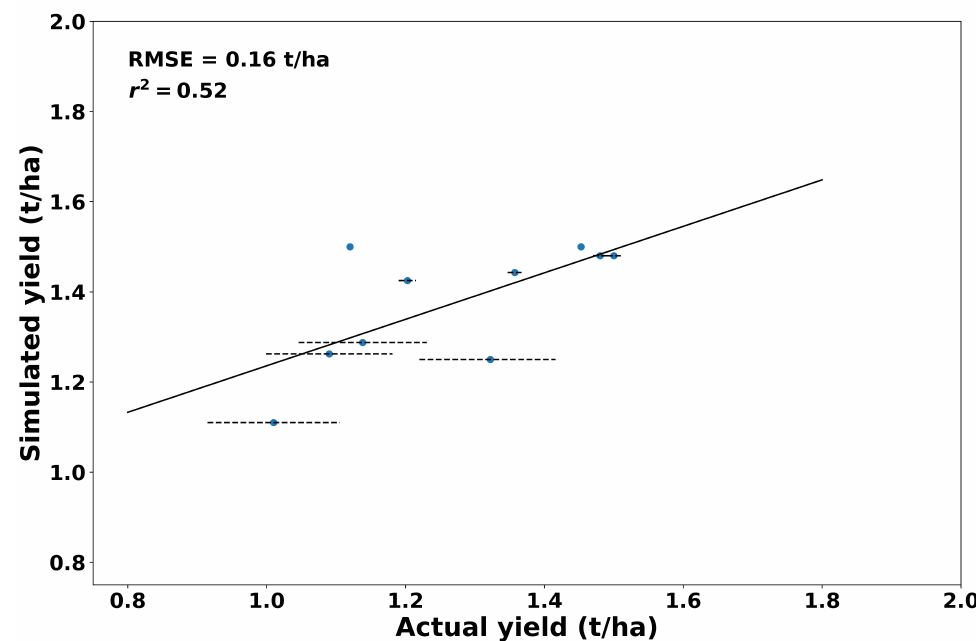
Figure 4. Correlation fit for actual on-farm yield versus simulated yield computed at the same or nearest locations to the TAHMO stations used in this